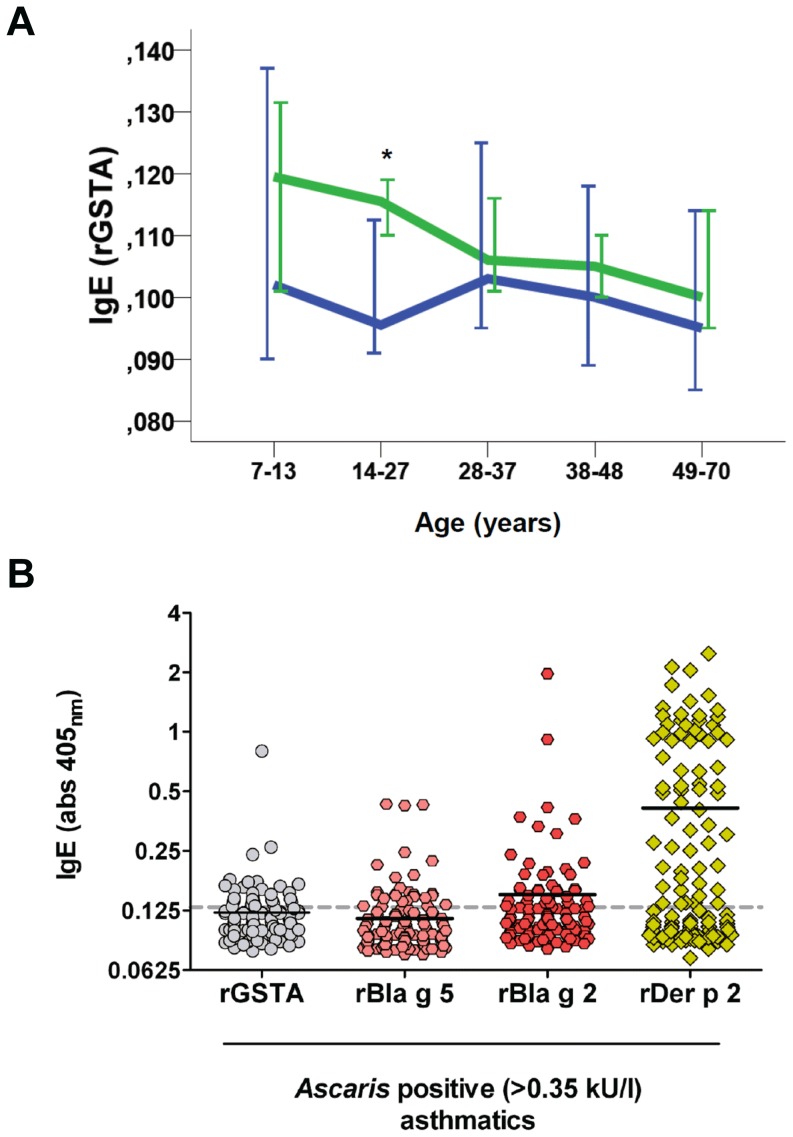
Frequency and strength of the IgE reactivity to rGSTA.(A) Specific IgE levels to rGSTA according to age groups. Green line represents asthmatics and blue line represents non-asthmatic controls. Error bars indicate 95%CI of the median IgE levels (B) A comparison between the strength of specific IgE levels to rGSTA and the cockroach GST (Bla g 5) in asthmatic patients sensitized to Ascaris (ImmunoCAP® >0.35 kU/l, n = 128). IgE levels to rBla g 2 and rDer p 2 were used as reference for the strength of IgE binding to non-GST allergens. Each dot indicates an individual serum.